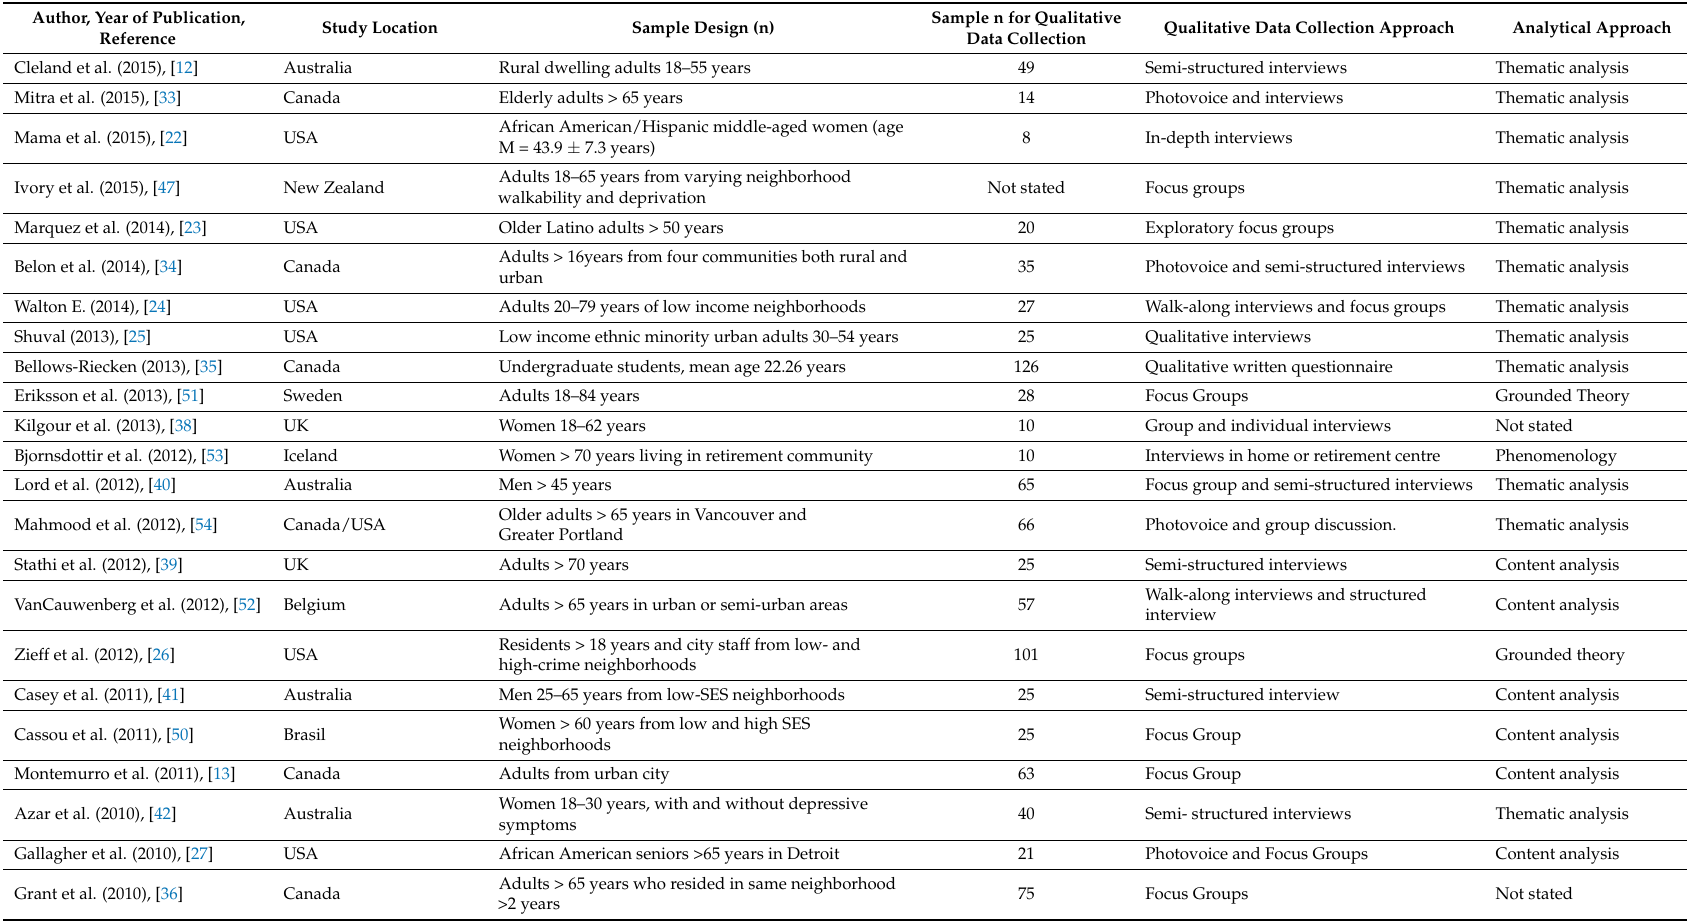
Table A1. Sample design, data collection approach, and analytical approach methods for studies included in the review ( n =